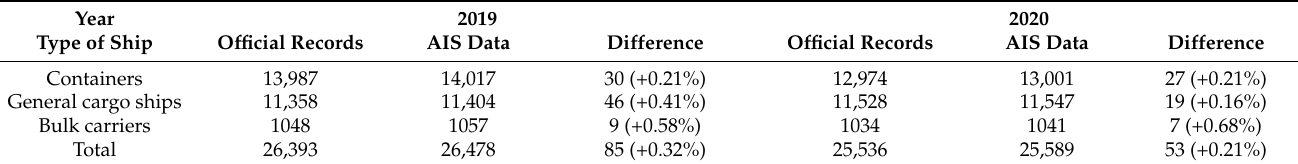
Table 3. Vessel arrival of containers, general cargo ships, and bulk carriers in BP in 2019 and